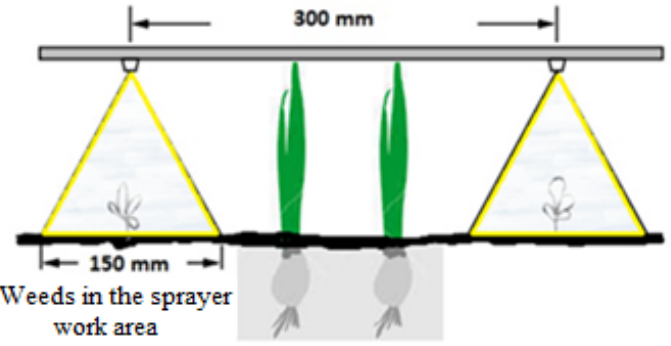
Figure 4. Diagram of the liquid distribution between two neighboring nozzles.